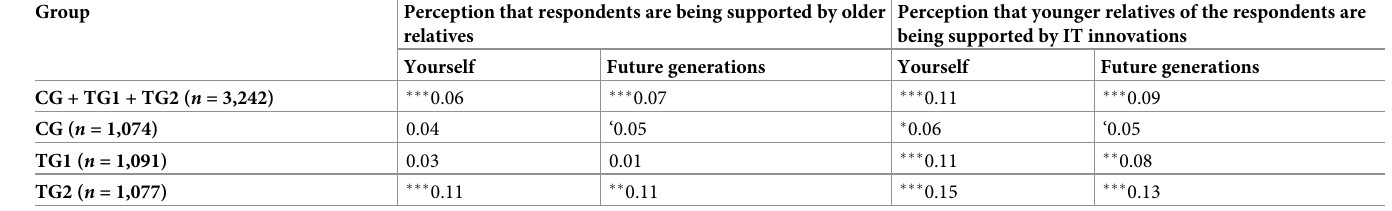
Table 7. Correlation coefficients between change in attitude ( D ) and sense of familial support. Group Perception that respondents are being supported by older relatives